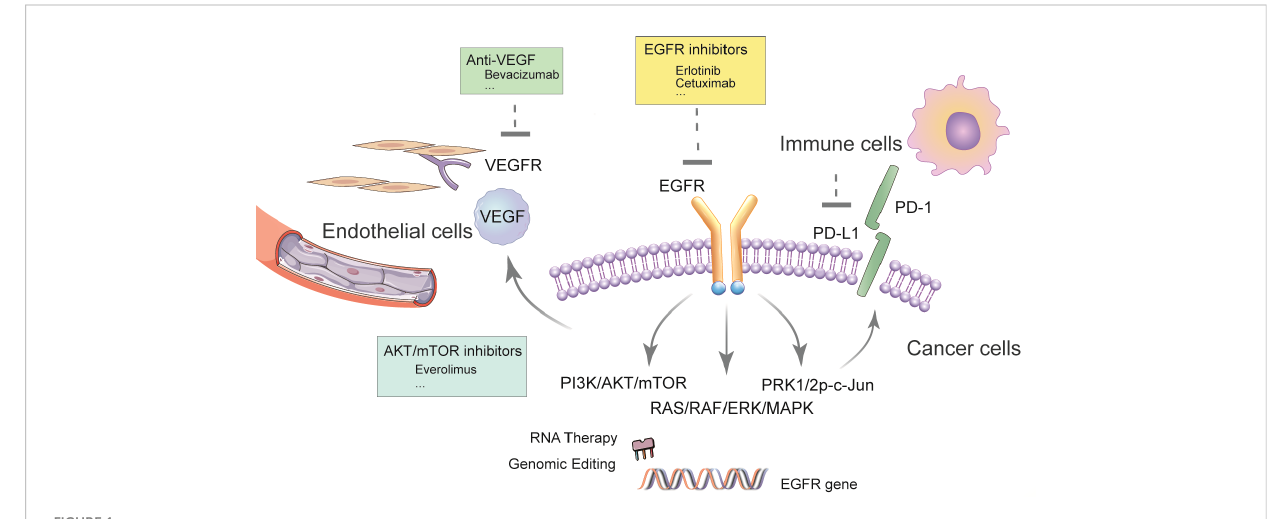
FIGURE 1 Schematic of EGFR-TKI-based regimen in